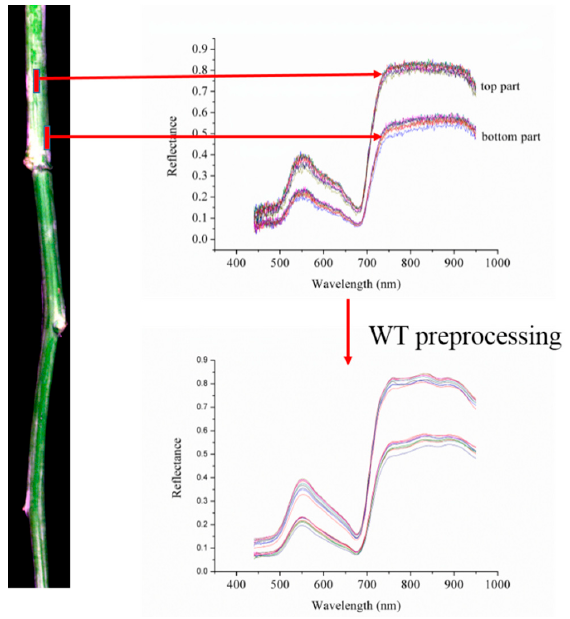
Figure3. Raw and WT preprocessed spectra of 10 pixels from the middle top and 10 pixels from side bottom of a randomly selected stem of sample set